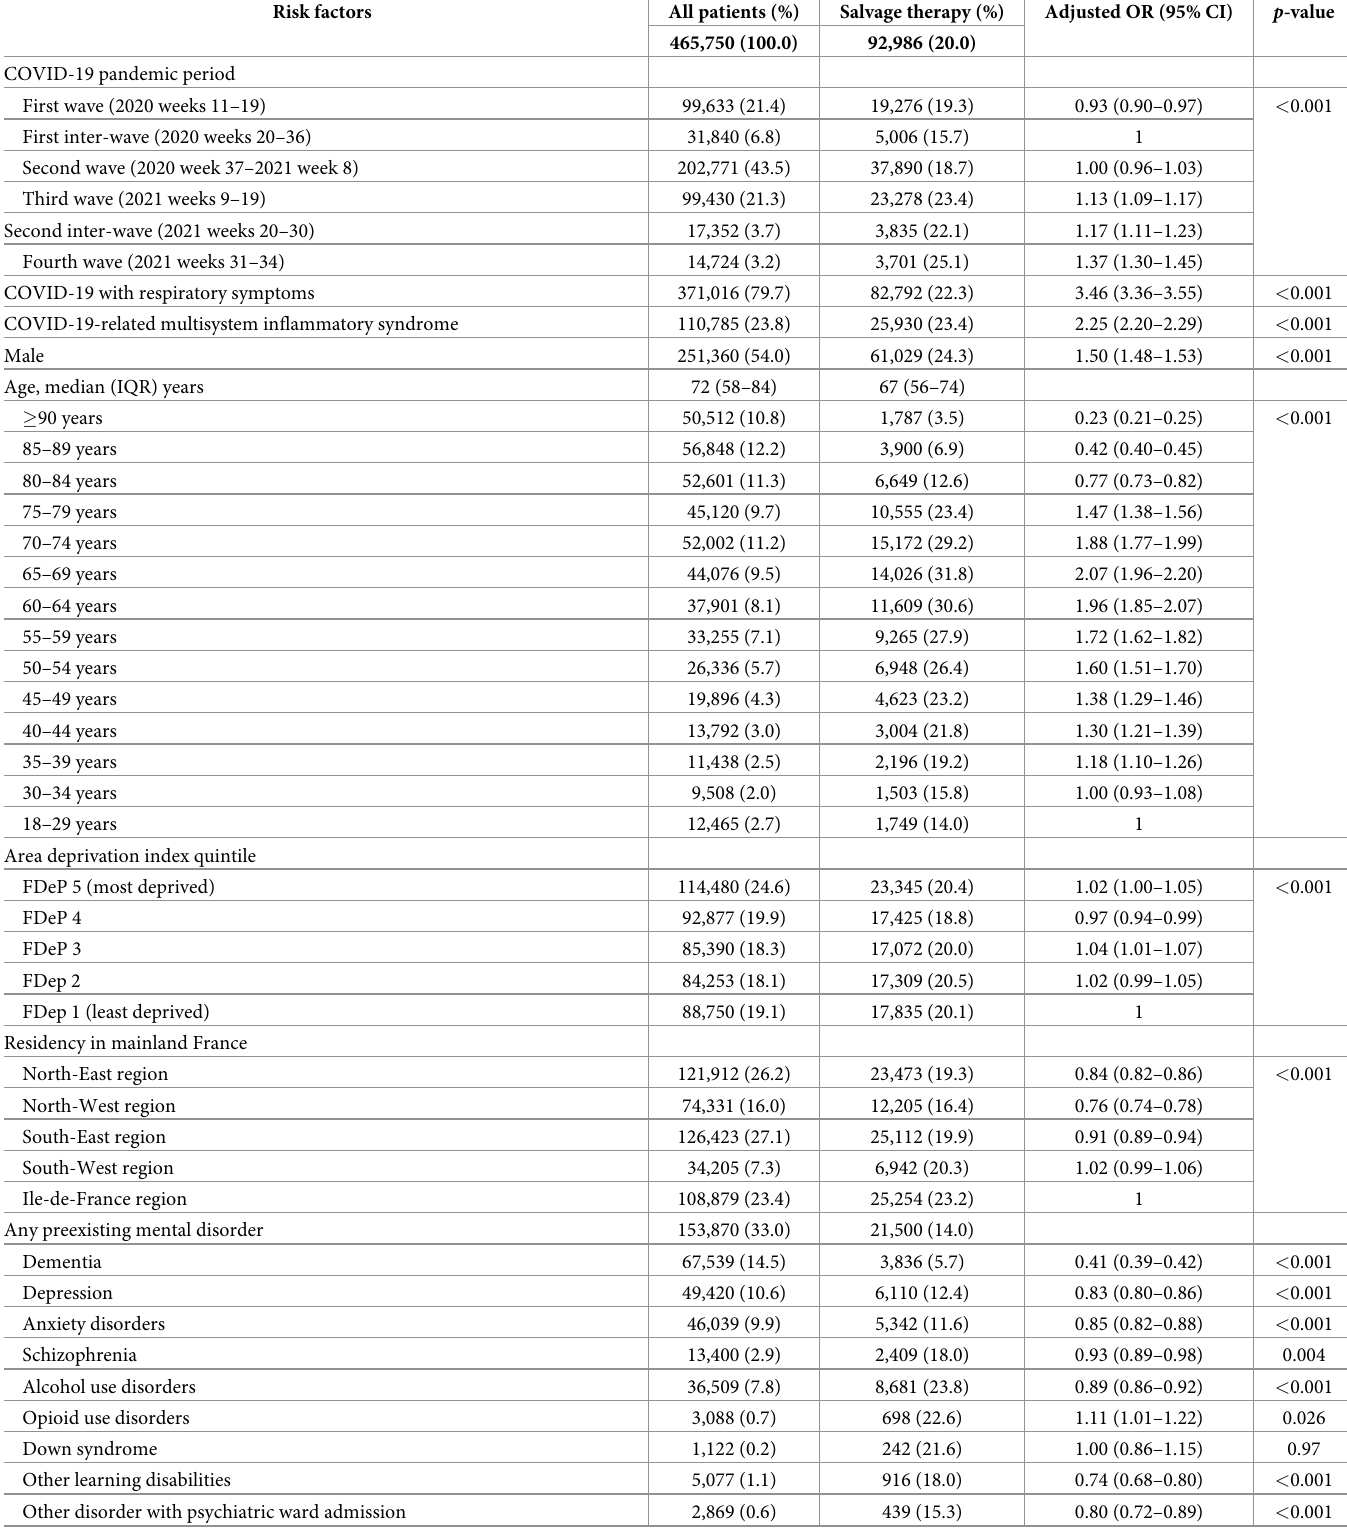
Table 2. Risk factors for salvage therapy of inpatients with symptomatic COVID-19 in France. Risk